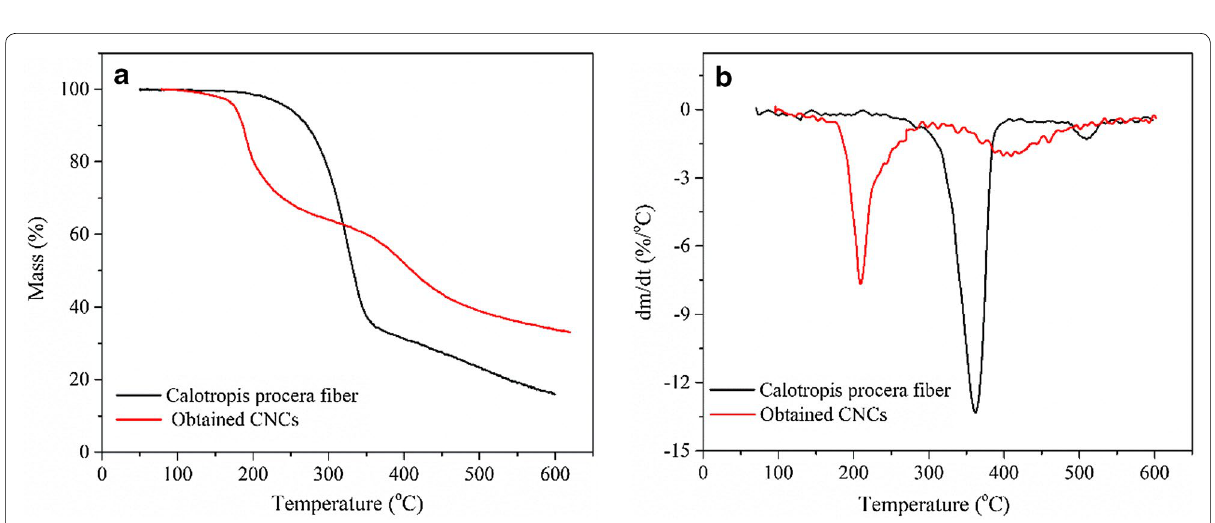
Fig. 5 a TG and b DTG analysis of Calotropis procera fiber and the obtained cellulose